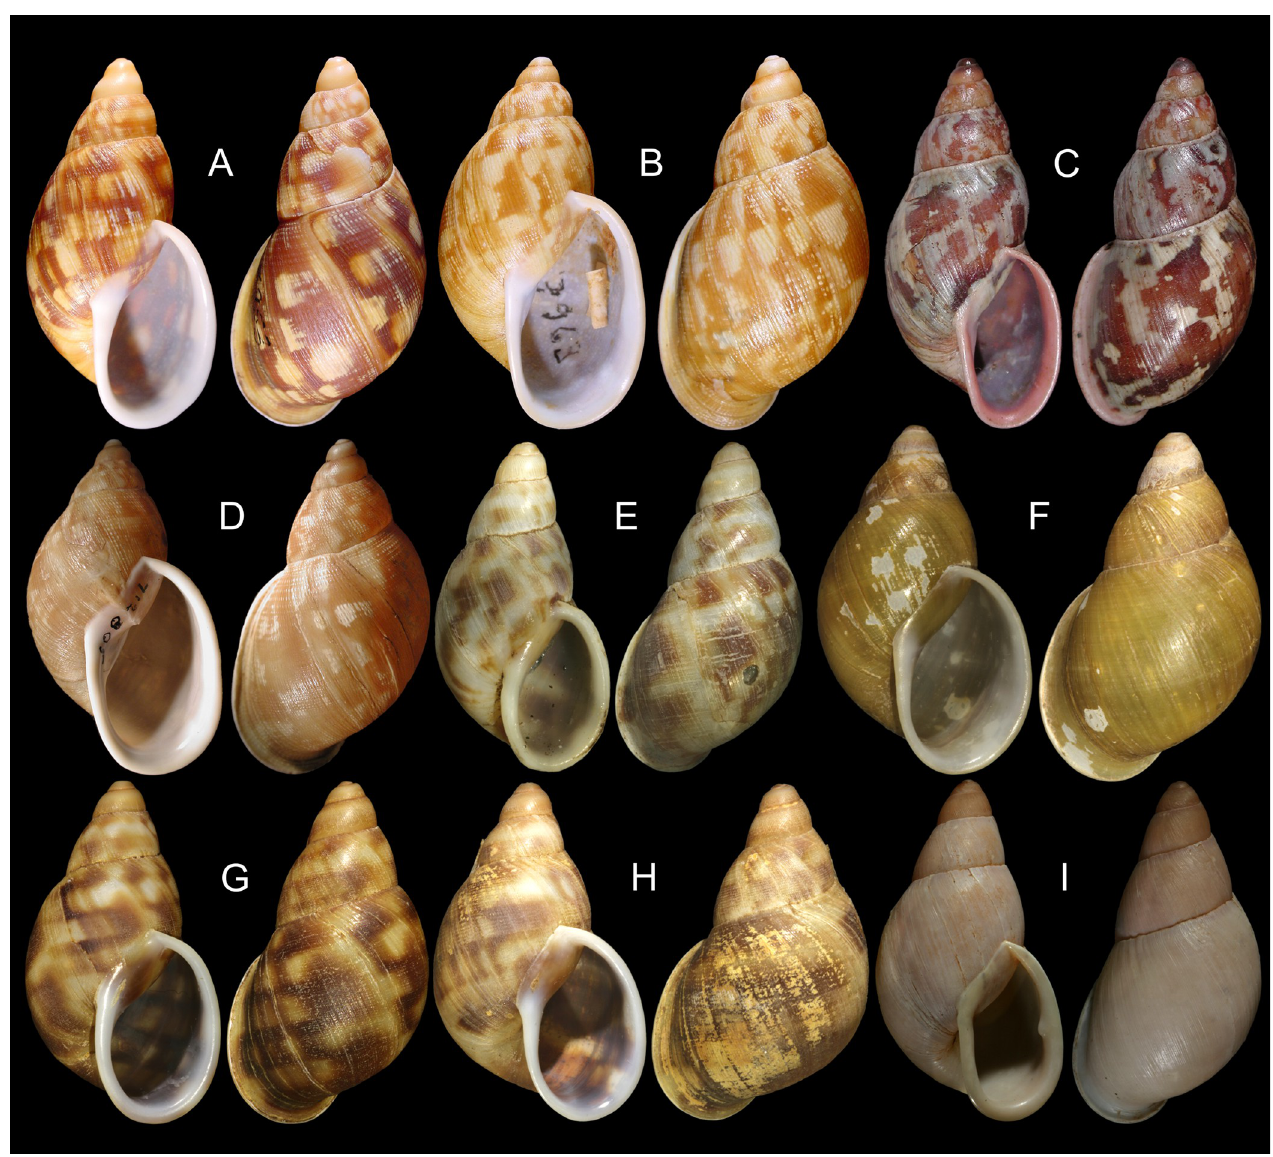
Fig 25. Gallery of shells of all Anthinus species, frontal and dorsal views. (A). A . albolabiatus , MZSP 7958 (L 50 mm). (B) A . miersi , MZSP 7963 (L 53 mm). (C) A . multicolor , MZSP 29620 (L 26 mm). (D) A . turnix , holotype USNM 712805 (L 50 mm). (E) A . synchondrus holotype MZSP 152074 (L 36.9 mm); (F) A . vailanti holotype MZSP 152891 (L 29.0 mm). (G) A . morenus holotype MZSP 152891 (L 35.8 mm). (H) A . savanicus holotype MZSP 154391 (L 32.5 mm). (I) Catracca uhlei holotype MZSP 151900 (L 44.2 mm). A to D extracted from Simone